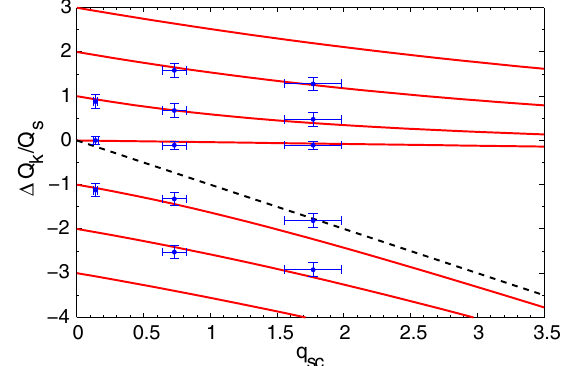
FIG. 12. The measured positions of the peaks in the horizontal tune spectra for different U 73 þ beam intensities together with the analytical curves from Eq. (8) using the space charge tune shift estimated from the beam parameters in Table I. The dotted line corresponds to the incoherent tune shift. The error bars for the vertical plane correspond to the width of measured modes (see text). In the horizontal plane the error bars are estimated by the propagation of uncertainties (see